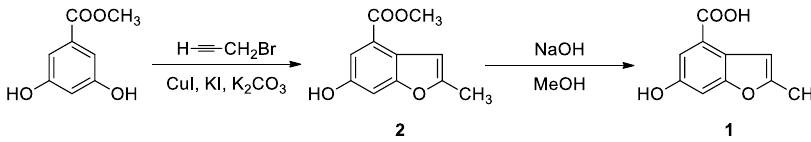
Figure 1. 7-Hydroxy-2-methyl-4-oxo-3,4-dihydro-2 H -benzopyran-5-carboxylic acid ( I ).